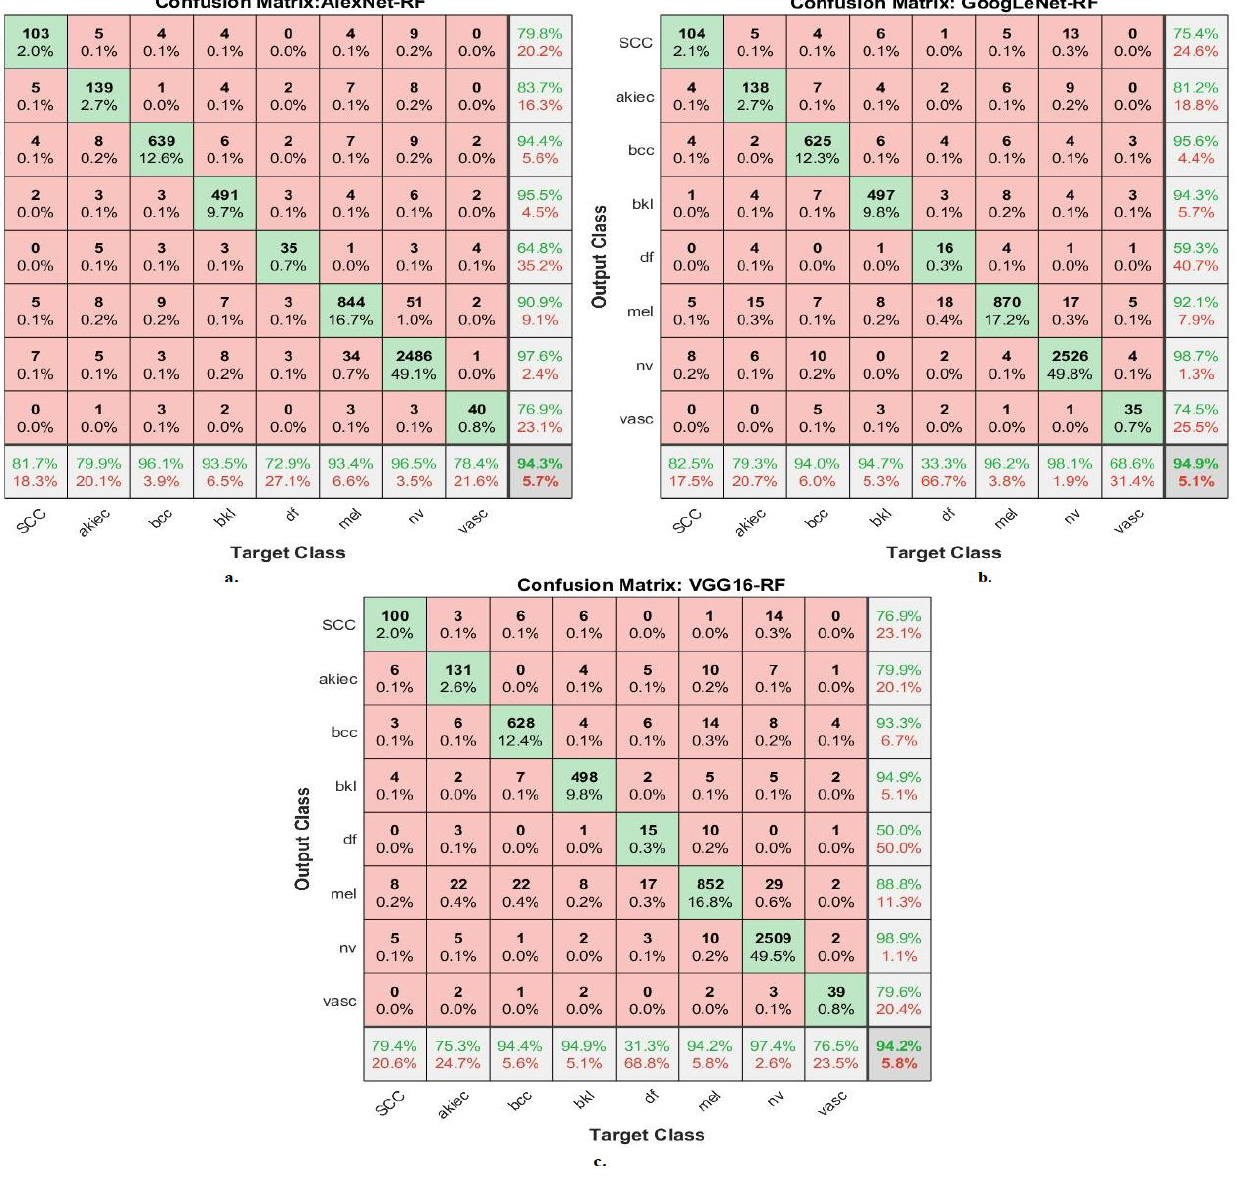
Figure 12. Confusion matrix for displaying performance results of hybrid CNN-RF models based on ROI using the GAC method for early diagnosis and discrimination of skin cancer from other skin lesions ( a ) AlexNet-RF ( b ) GoogLeNet-RF ( c ) VGG16-RF.